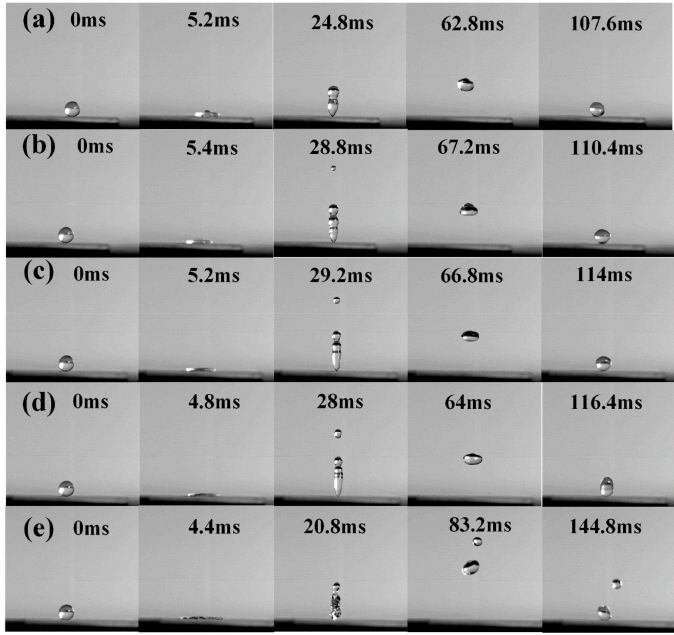
Figure 8. Droplet released from different heights to impact on the ED2 sample: ( a ) from the height of 20 mm (v = 0.625 m/s, We = 14.378), ( b ) from the height of 30 mm (v = 0.766 m/s, We = 21.568), ( c ) from the height of 40 mm (v = 0.885 m/s, We = 28.757), ( d ) from the height of 50 mm (v = 0.989 m/s, We = 35.946) and ( e ) from the height of 100 mm (v = 1.399 m/s, We =